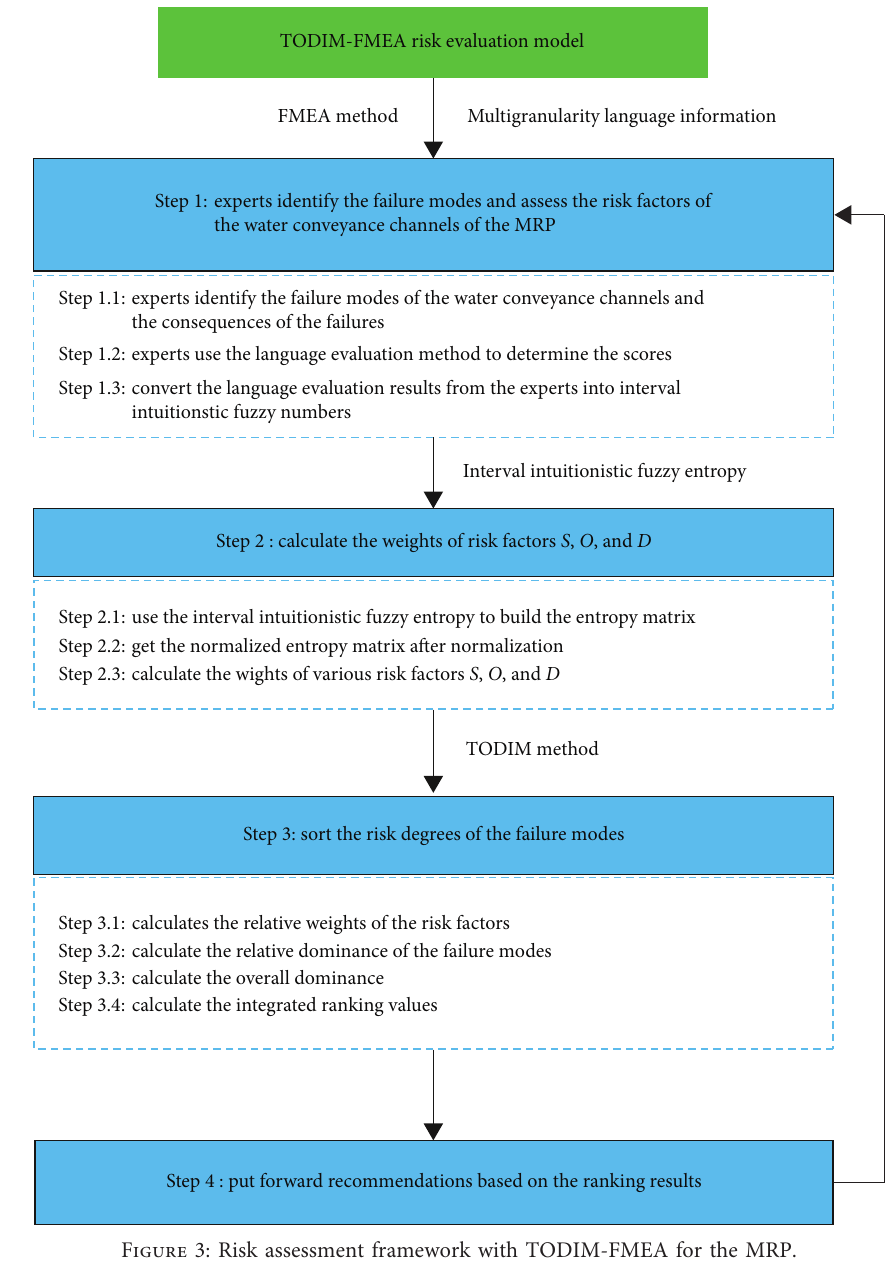
Figure 3: Risk assessment framework with TODIM-FMEA for the